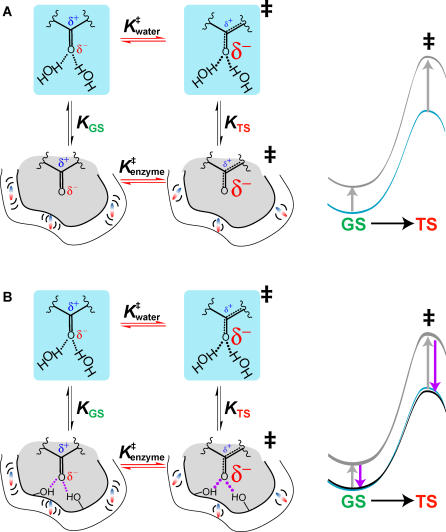
Model for the KSI Active Site Environment and Energetic ConsequencesCharge accumulates on the oxyanion in the transition state. Transfer from water to a mock active site (or mutant) lacking hydrogen bonds (A) results in a desolvation penalty that is larger in the transition state than in solution as the KSI active site provides only a limited number of dipoles (colored bars) partially pre-oriented to stabilize the transition state charge distribution. Hydrogen bonds, when added back to the active site (B), shorten and strengthen (larger dots and purple arrow) in the transition state on the enzyme, as suggested by the large value of −ΔΔH. Enzyme dipoles rearrange and become more conformationally restricted in the transition state, shown in both (A) and (B), as suggested by the large value of Δ(TΔS). The energetic sum of these interactions results in a free energy reaction profile similar to that in solution.